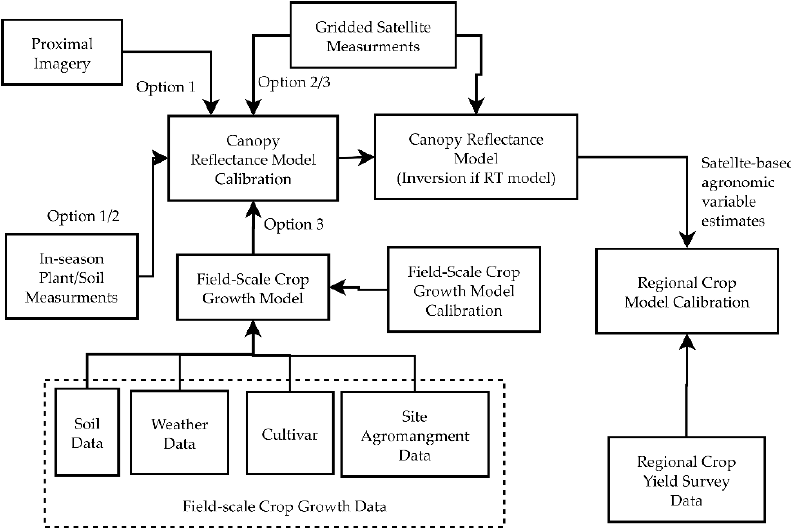
Figure 2. Flowchart of proposed method of calibrating canopy reflectance models as compared to traditional options. The traditional options (1 and 2) use collocated in-season plant/soil measurements along with proximal or satellite imagery, while the proposed Option 3 uses field scale crop growth simulations in place of the in-season measurements. The calibrated canopy reflectance models can be used in the future for regional crop model calibration.